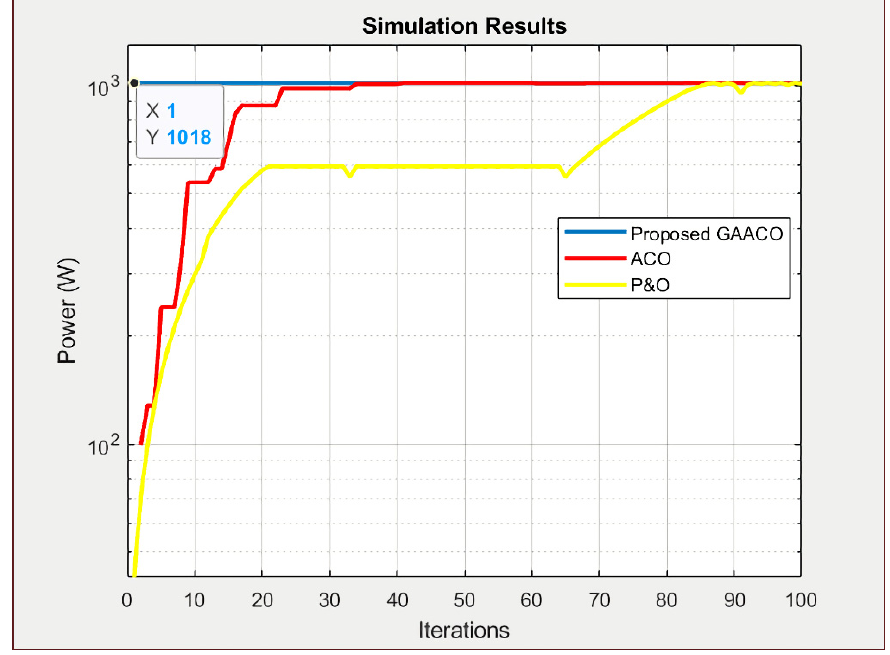
Figure 8. GA-ACO MPPT simulation results compared with those from the P&O and conventional ACO MPPTs in Case 2.